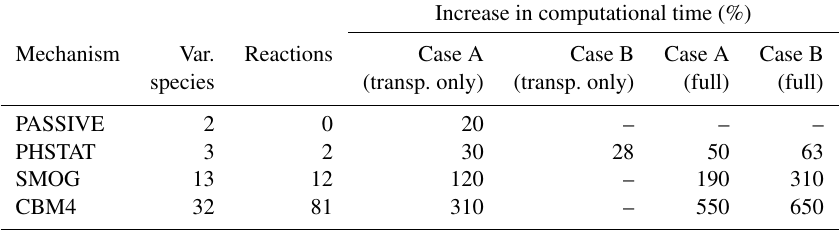
Table 2. Increase in computational expense of a simulation with the PASSIVE, PHSTAT, SMOG and CBM4 mechanisms relative to a simulation without chemistry. For case A, the simulations were for a model domain with 96 × 96 × 320 grid points and a grid width of 10m. For case B, the simulations were performed for a model domain with 671 × 671 × 312 grid points and a grid width of 10m. Both runs were made in scalar mode for one full day. The term “transp. only” indicates the relative expense when solely the transport of the considered compounds is calculated and chemical transformation is switched off, and “full” refers to the run with transport as well as chemical transformations.